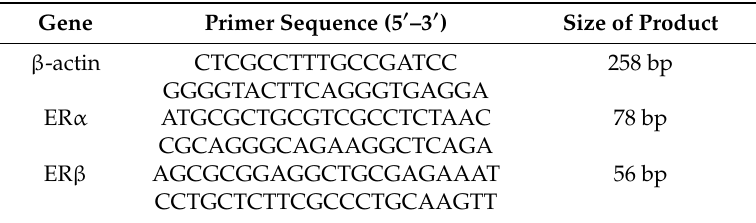
Table 2. Primers used for